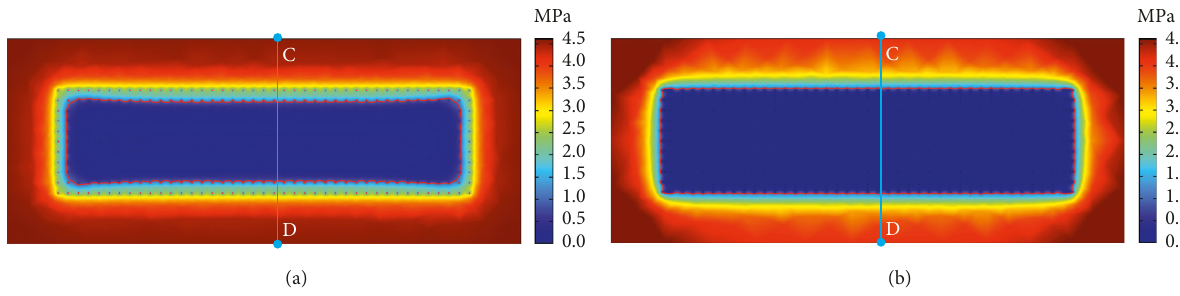
Figure 7: Gas pressure in the coal seam after 180 days of extraction. (a) Original arrangement. (b) Optimized